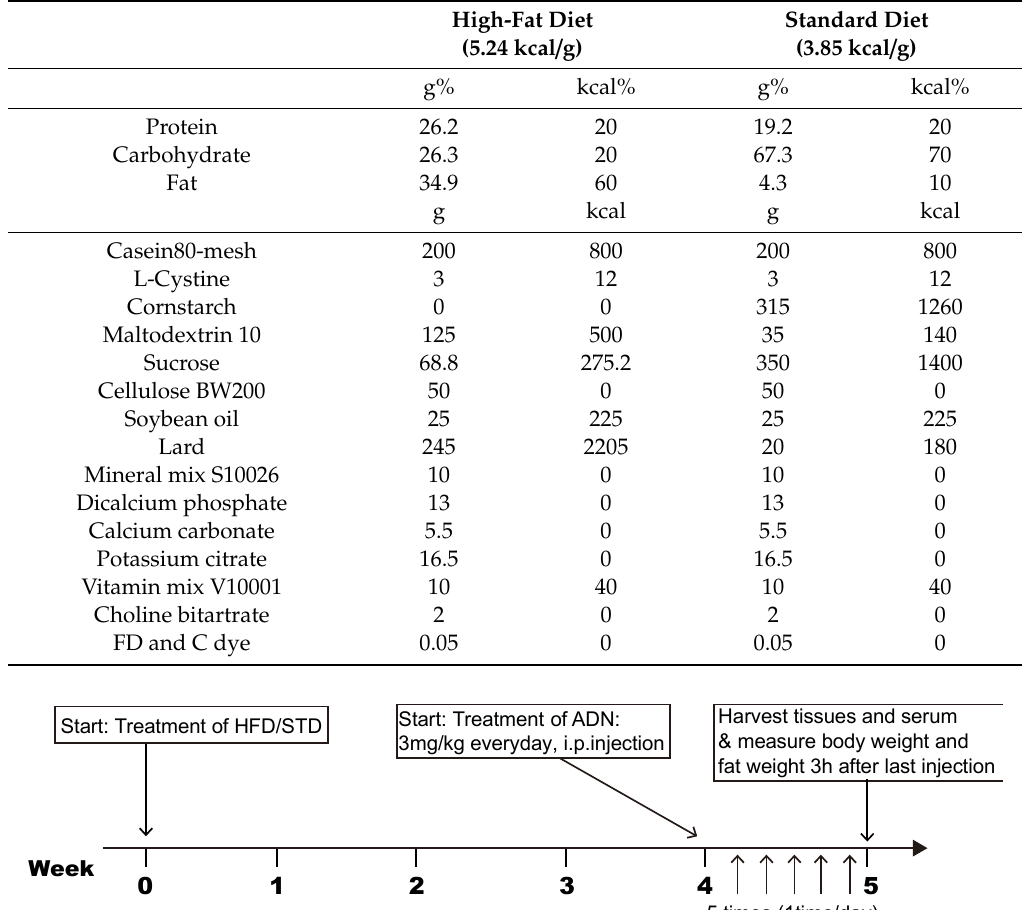
Table 1. Components of the HFD and STD.